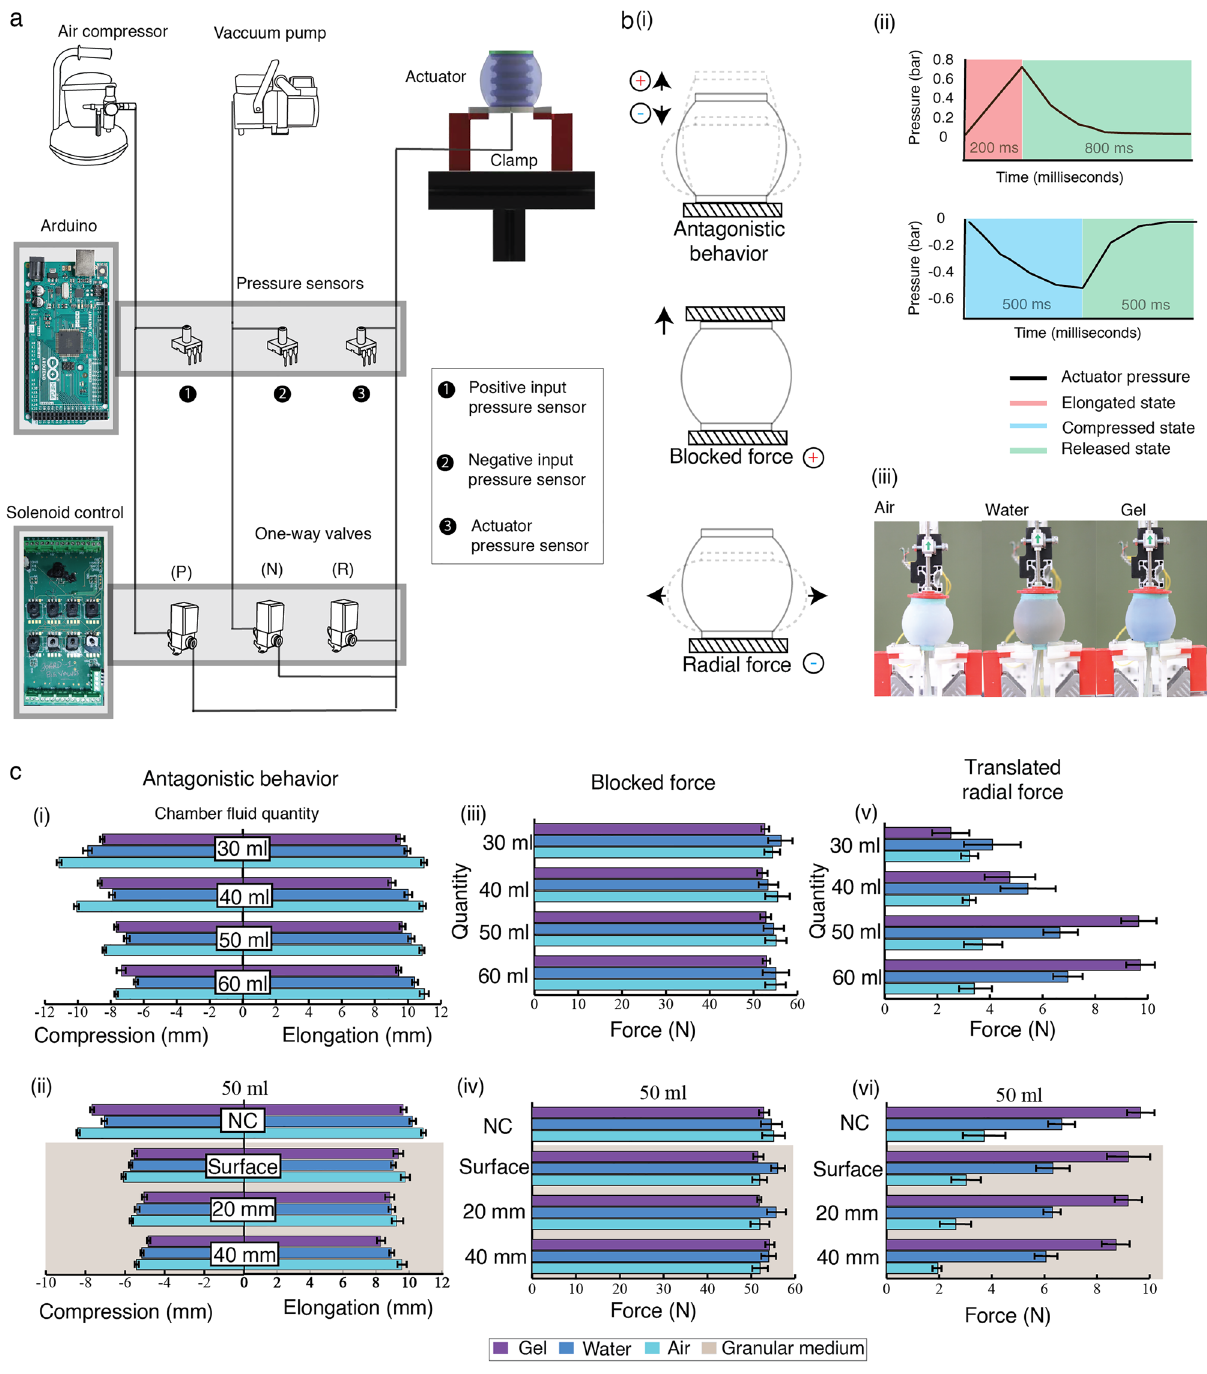
Figure 2. Characterization of peristaltic soft actuator (PSA). ( a) Schematic of pneumatic system for characterization experiments, One-way Valves: positive pressure (P), negative pressure (N) and release (R). ( b) (i) Simplified illustration of the characterization type (antagonistic behavior, blocked force, radial force). (ii) Actuator pressure variation with time for positive and negative pressure (iii) Variation in internal fluid for characterization (air, water, gel). ( c) Characterization results for modules with varying internal quantity and type of fluid in two different conditions NC (Normal Condition) and granular media (i) The air-filled module recorded higher deformation (both in elongation and compression) than both gel and water due to higher compressibility and a lower bulk modulus. An increase in the volume of fluid resulted in fewer deformations; (ii) a steady decrease in the deformation of the actuator with an increase in depth; (iii) blocked force recordings showed no variation with the change in fluid type and volume; (iv) the depth increase in the blocked force did not vary; (v) the increase in fluid quantity resulted in an increased force value for water and gel-filled modules but not for air-filled modules; (vi) all modules recorded lower forces with an increase in